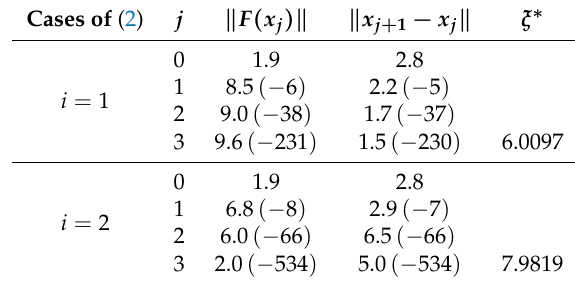
Table 5. Computational results on a boundary value problem